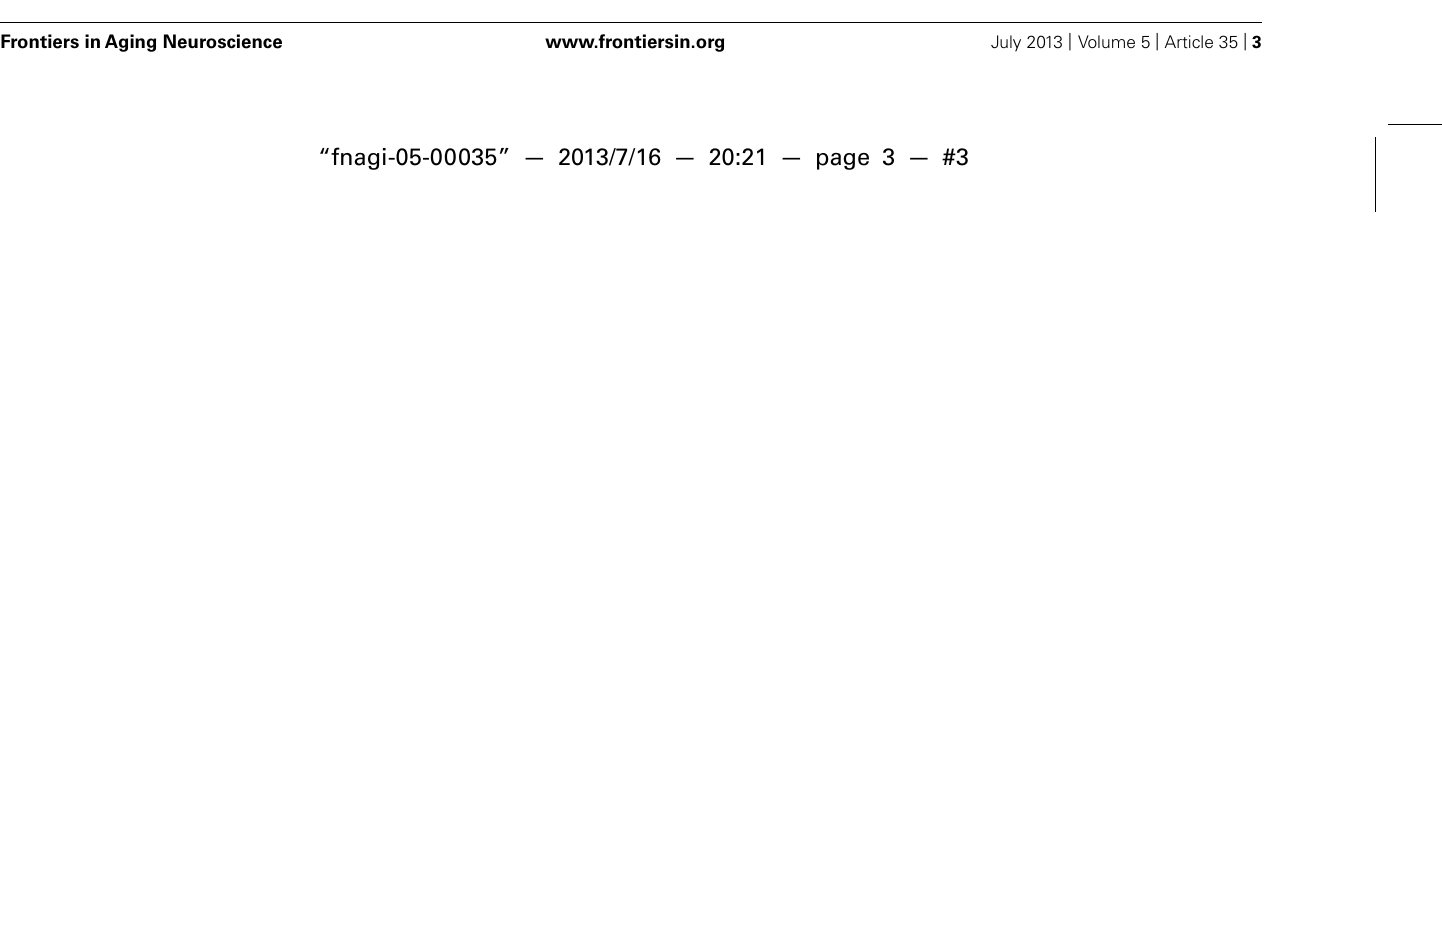
analytical limitations, will greatly impact on our ability to correctly predict the metal association, and therefore function, as a large number of these proteins are